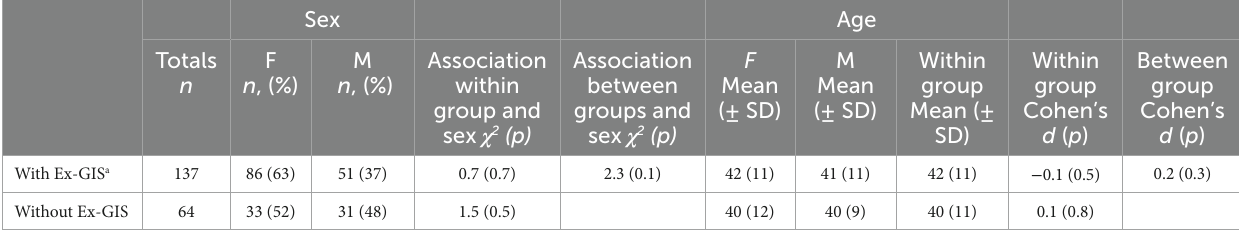
TABLE 1 Participant demographics of endurance athletes with ( n = 137) and without ( n = 64) reported exercise-associated gastrointestinal symptoms with Chi-square comparisons for categorical data (sex) and independent samples t-test for normally distributed data